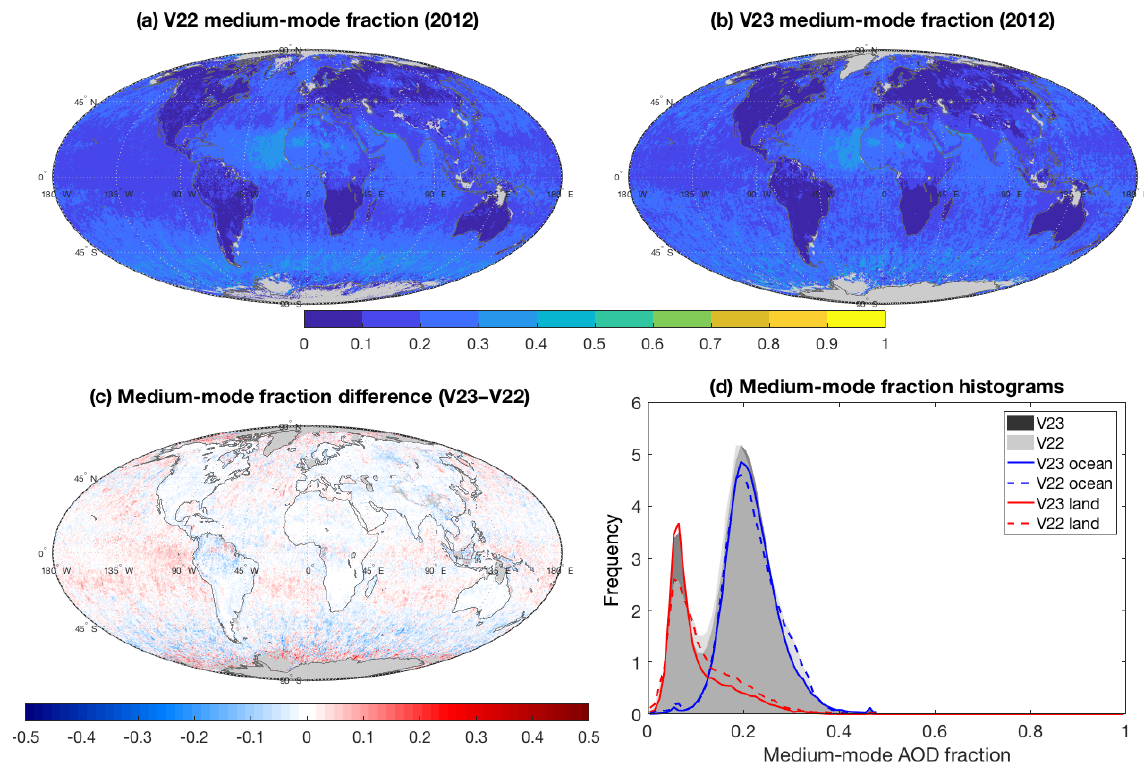
Figure 13. As in Fig. 7 except for the MISR-retrieved medium-mode AOD fraction. AOD weighting is applied in data averaging.